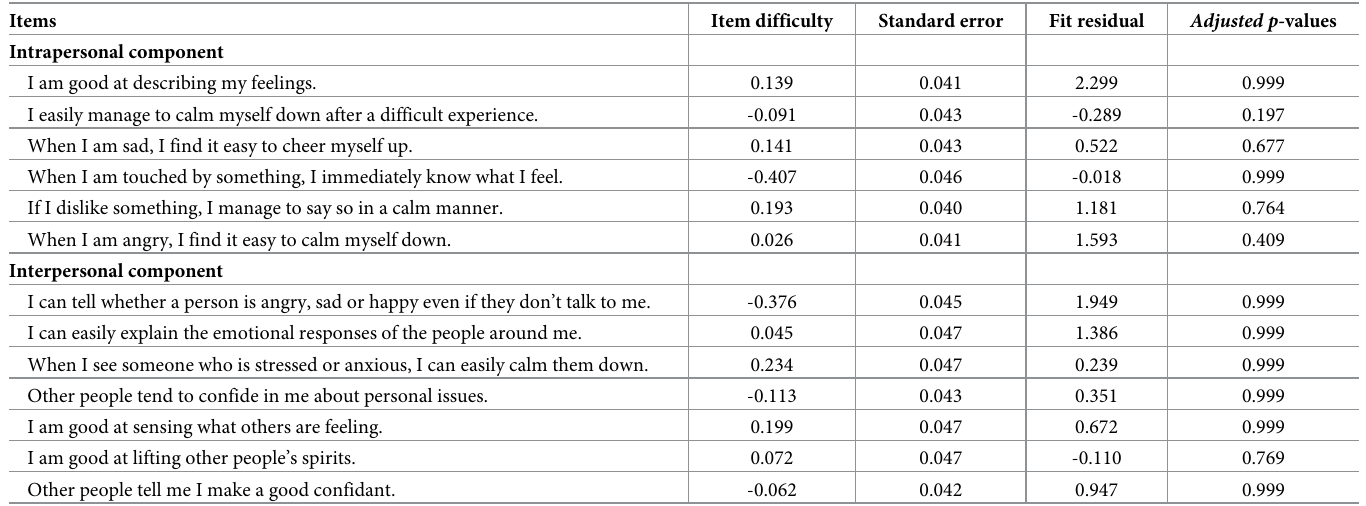
Table 2. Item difficulties and fit statistics of the Short-PEC by